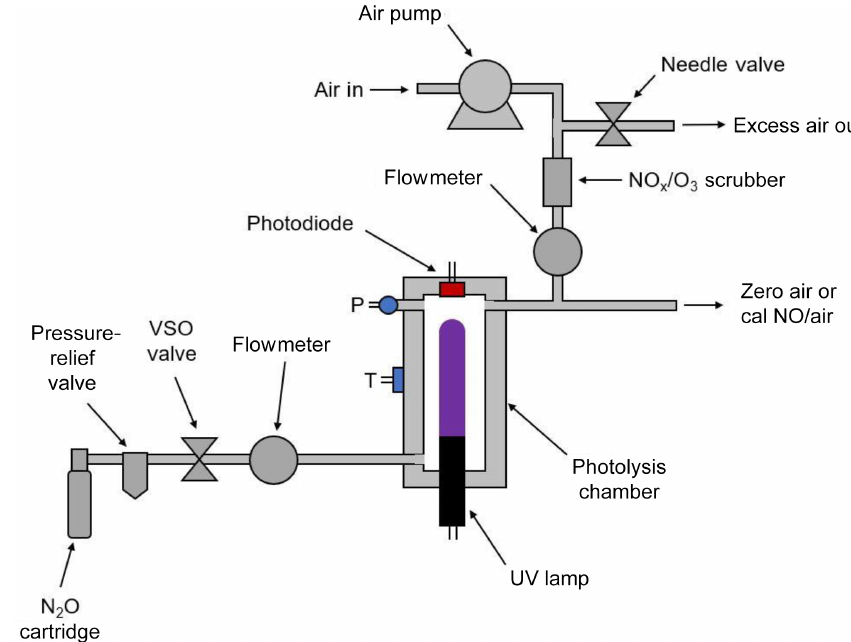
Figure 2. Schematic diagram of the 2B Technologies Model 408 Nitric Oxide Calibration